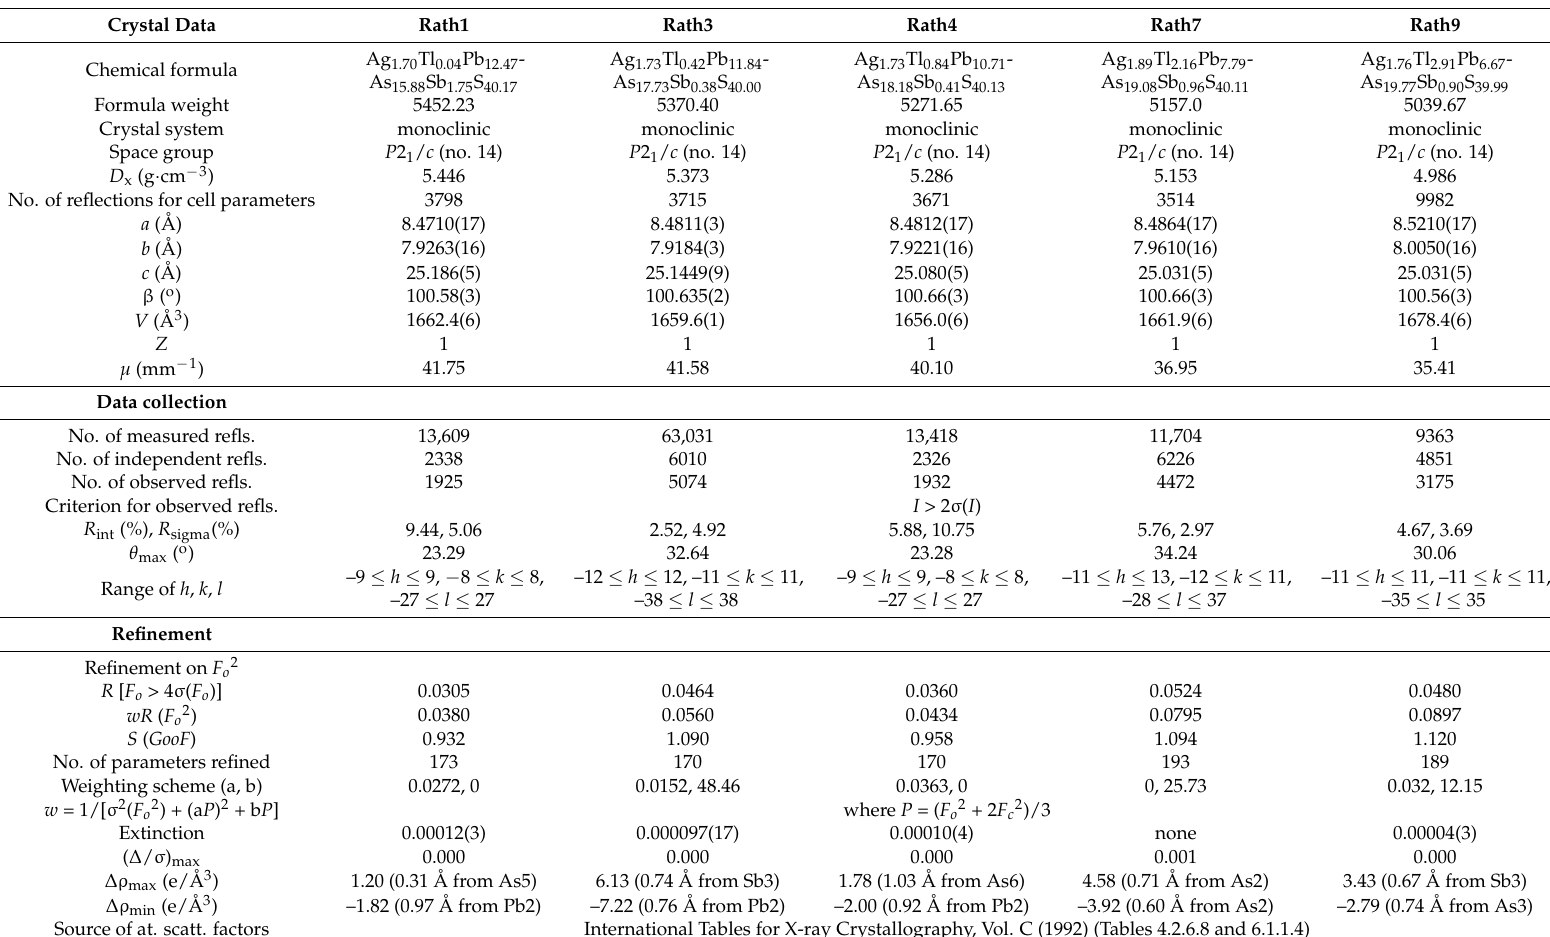
Table 4. Crystal data and summary of parameters describing data collection and refinement for five rathite fragments with different Tl contents and Pb:As ratios (rath1, rath3, rath4, rath7, and rath9).